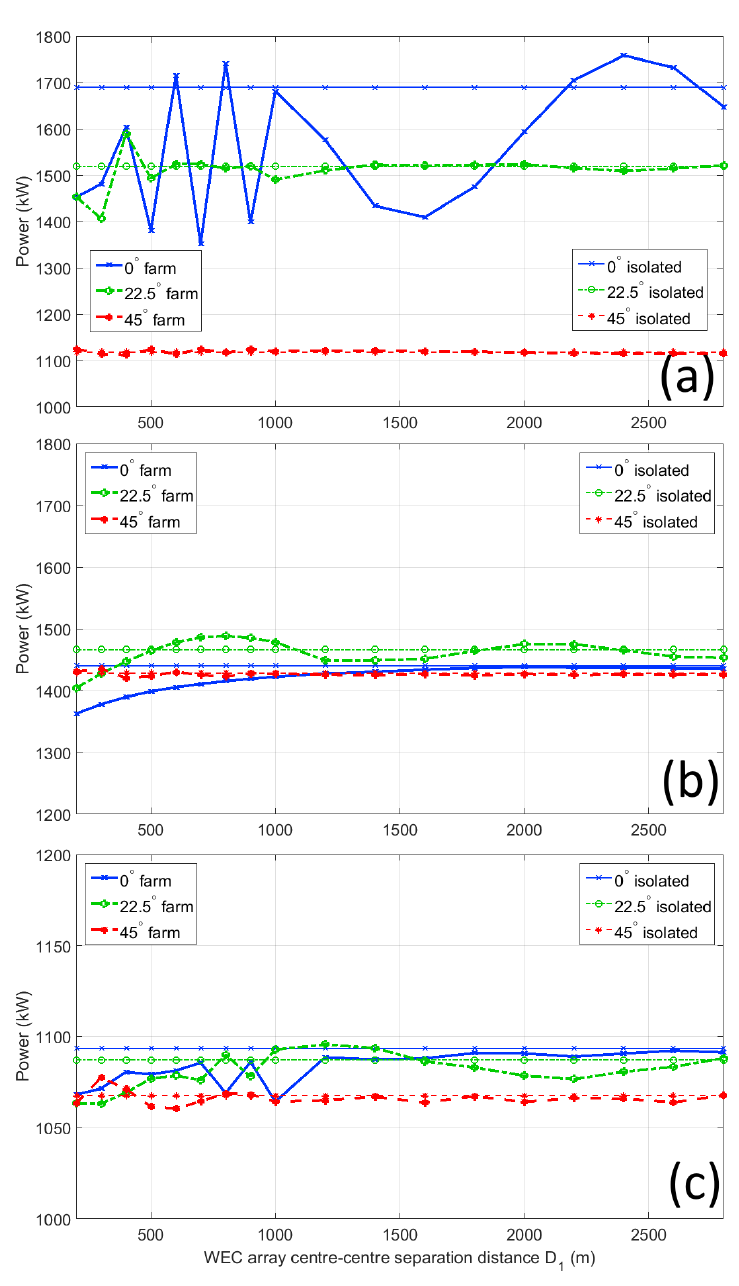
Figure 6. Power output of the WEC farm for various Interarray separation distances D 1 for regular waves of T = 6 s, ( a ) T = 8 s ( b ), and T = 10 s ( c ) for β = 0 ◦ (solid line) 22.5 ◦ (dash-dot line), and 45 ◦ (dash line) thin horizontal lines indicated 2 × P array . Thick lines indicate P farm